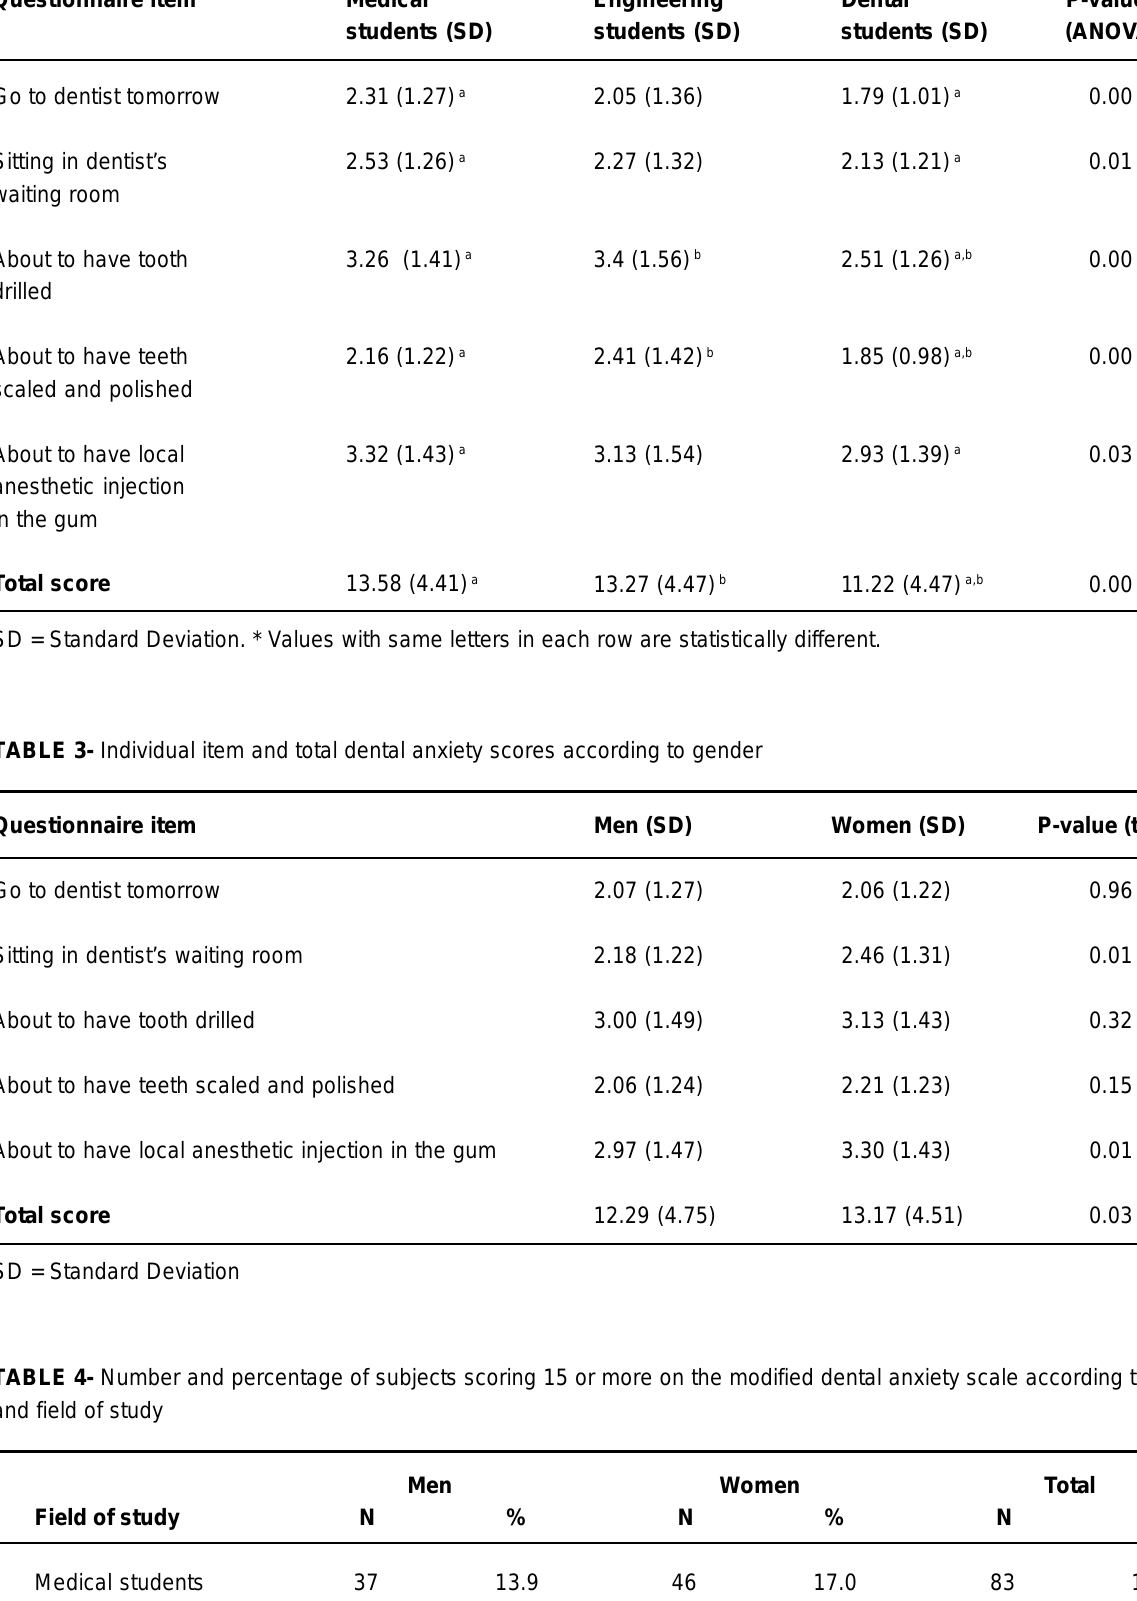
TABLE 2- Individual item and total dental anxiety scores according to the study field